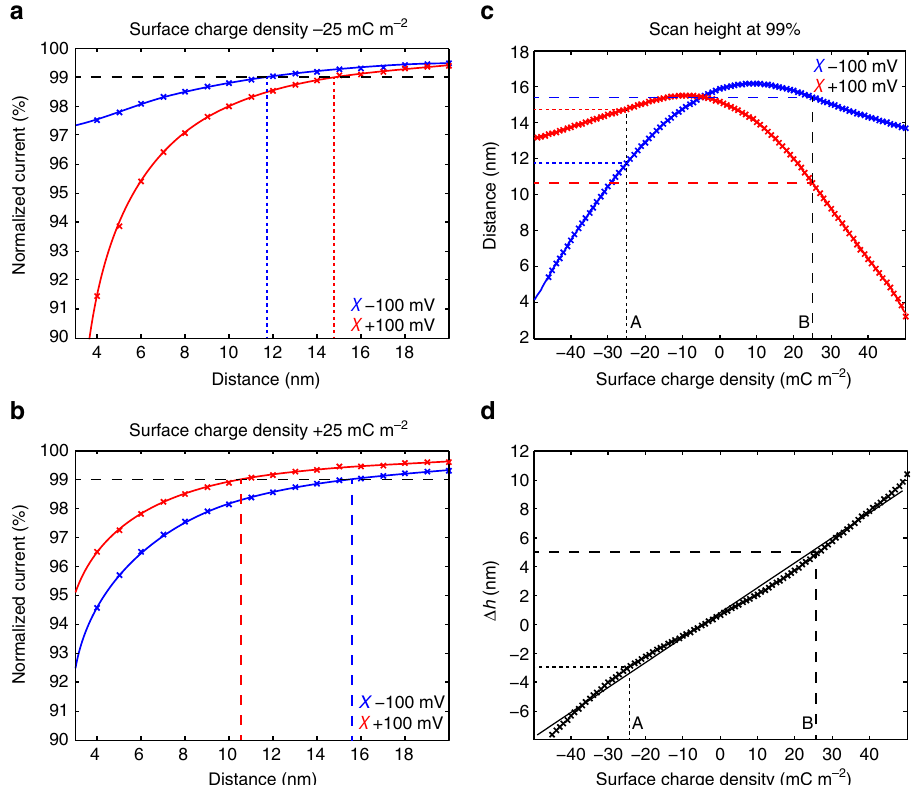
Figure 3 | FEM simulations of the QSCM mode. Approach curves from PNP simulations are given to a negatively charged substrate of (cid:2) 25mCm (cid:2) 2 ( a ) and a positively charged substrate of þ 25mCm (cid:2) 2 ( b ) with bias potentials of 100mV (red) and (cid:2) 100mV (blue). The scanning height (99% of unperturbed current) is marked with straight dashed lines in a and b , and plotted as a function of SCD in c . The difference (scanning at negative potential minus positive potential) is shown in d and a linear fit is given. The slope ( m h ¼ 0.172nm (mCm (cid:2) 2 ) (cid:2) 1 or m s ¼ 5.79 (mCm (cid:2) 2 )nm (cid:2) 1 ) of the linear fit can be used to convert observed changes in scanning height into differences in the